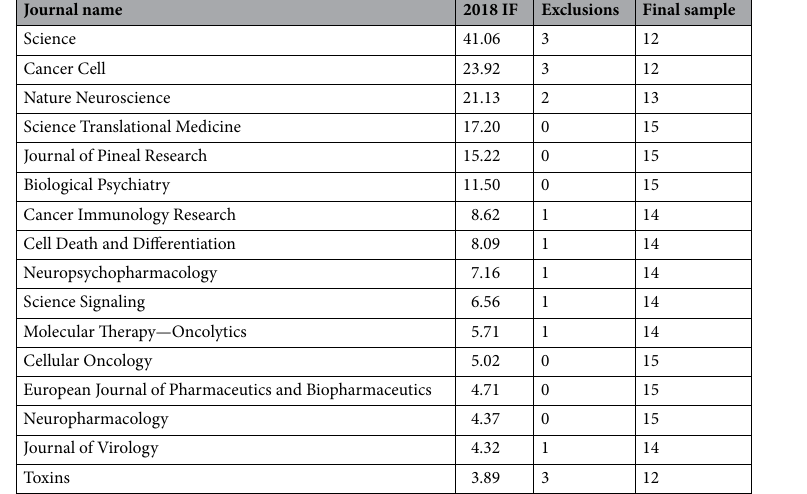
Table 2. Final list of journals included in the study (k = 16).